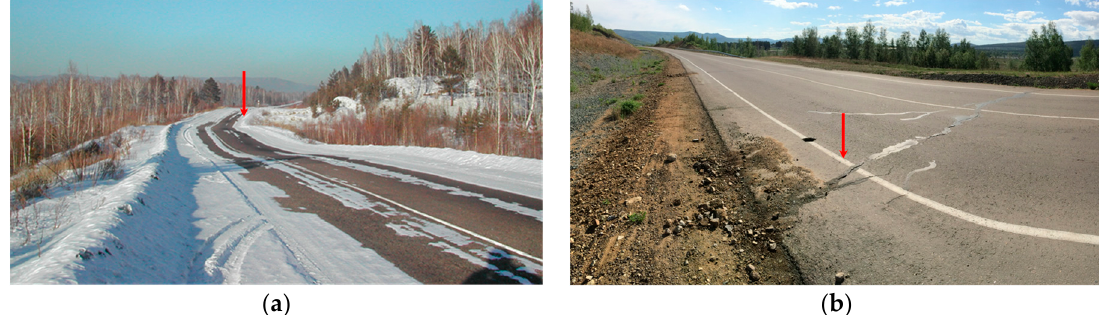
Figure 2. Deforming section of the Chita-Khabarovsk highway, 5 km from the Peschanka settlement. ( a ) 2006, photo by V. Kondratyev; ( b ) 2019, photo by V. Olenchenko.